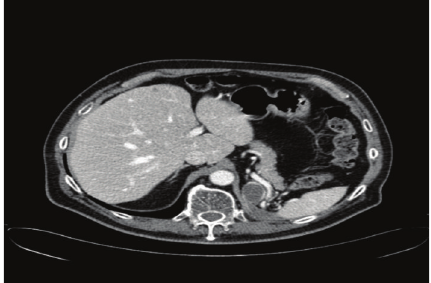
Figure 3: After 12 cycles of pazopanib there was a 30%